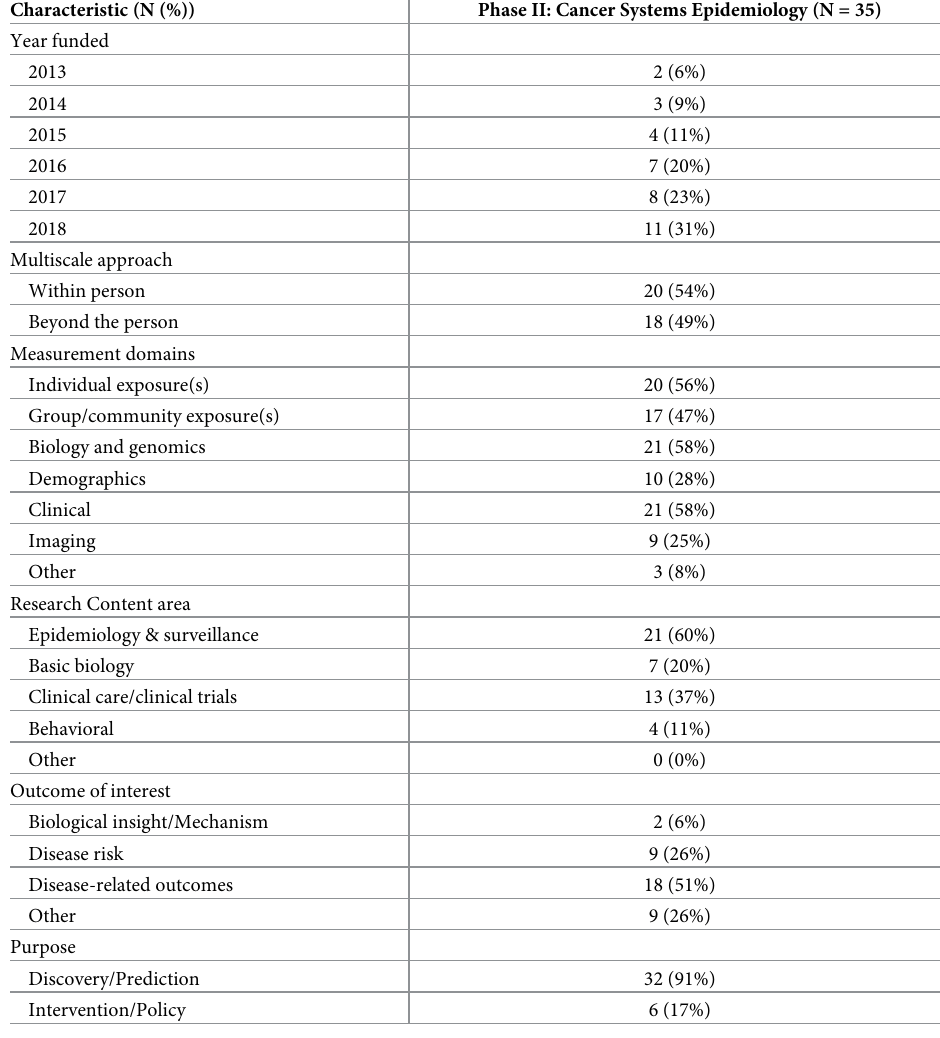
Table 4. Characteristics of phase II cancer systems epidemiology grants a